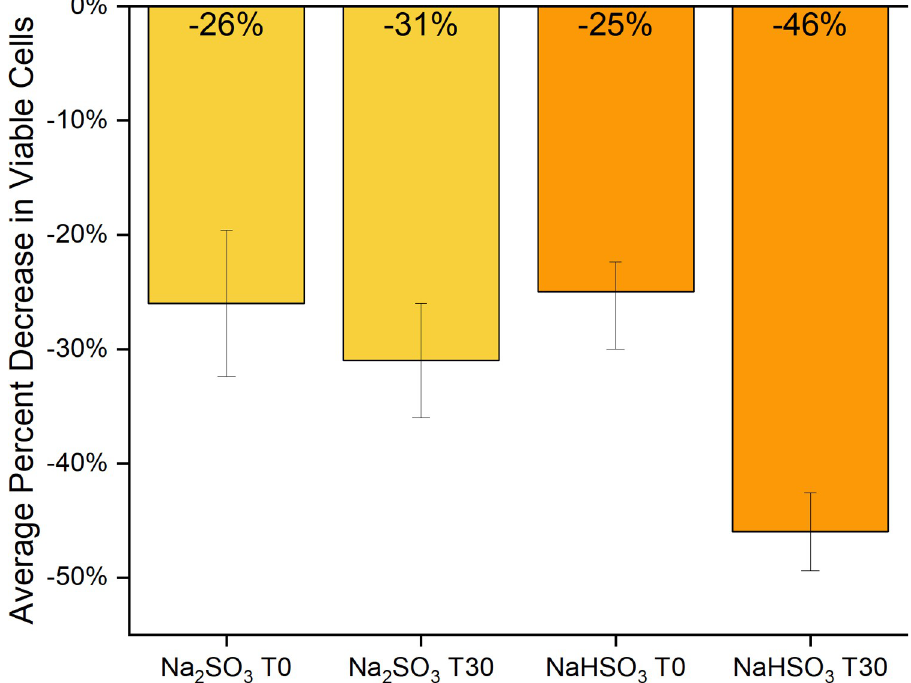
Fig 1. Average change in ATP activity after sulfite treatment. Raw data (RLU) of all saliva samples (F1-F8 and M1-M2) treated with Na 2 SO 3 or NaHSO 3 compared to controls was used to determine the average % decrease of viable cells (based on ATP activity) in each at time 0 (T0) and time 30 (T30). The standard error of each test group was calculated, and evidence of observed difference was confirmed by both the paired t-test and the two-way ANOVA (Table